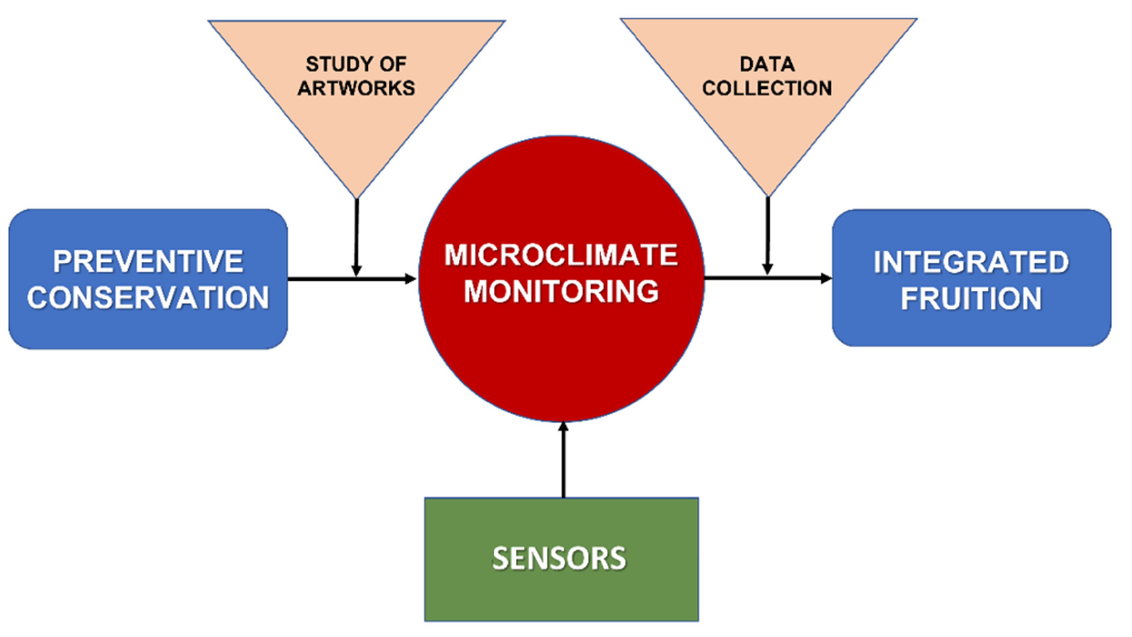
Figure 1. Description of the approach underlying the research: microclimate monitoring is the base of preventive conservation. In this context the study aimed at understanding the artwork has a fundamental role. The data collected by the sensors of the microclimatic parameters and the information obtained with the diagnostic techniques allow the integrated fruition. Table 1. Temperature and relative humidity reference and deviation values for different categories The STMicroelectronics STEVAL-MKSBOX1V1 was used as a wireless IoT-based de- of artifacts (from UNI10829:1999). vice for measurement of the microclimate parameters. The data are transmitted through Bluetooth ® low energy. In particular, the temperature, humidity and vibrations were measured on a painting, realized by the painter Giuseppe Patricolo in the first half of 19th century and depicting The Deposition . Its structure is quite heterogeneous, with a painted canvas fixed to a wooden support by a thin layer of white mortar. The artwork, whose particular shape gives it a concave structure, is 3 m high and 2 m wide and is placed inside a niche in the Santa Caterina Monastery in Palermo (Italy). The measurement system is schematized in Figure 2. As it can be noted, it presents various functionalities and the management of the measurands, the data logger and com- munication are accomplished through an ultra-low-power STM32L4R9 microcontroller. The system is able to manage the STTS751, used as temperature sensor, the HTS221, used as capacitive humidity sensor and the LIS2DW12, used as 3-axis accelerometers. Table 2 synthetizes the main features of the adopted sensors. A 3.3 V 1000 mAh Li-Polymer battery was used as a power supply of the measurement system. Figure 3 shows the board used for the monitoring of the painting. It should be noted that thanks to its compactness, performance in terms of data transmission, measurement approach and general features, this kind of sensor can be also applied to different exhibition spaces as well as directly applied on a large variety of specific works of art, e.g., painting on different supports, wooden frames, statues and